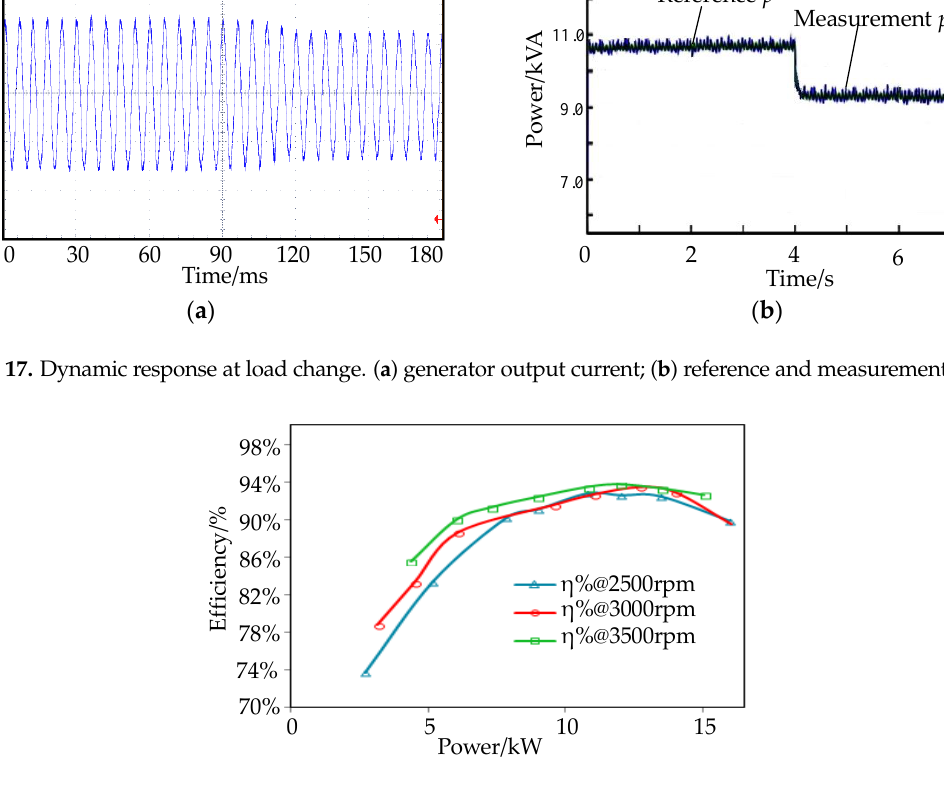
Figure 18. Generator efficiency curves at different rotating speed with designed control stretagy.